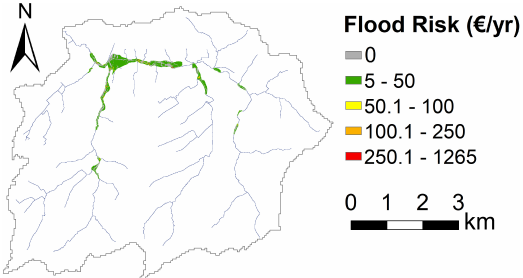
Figure 8. Flood risk, expressed as expected annual damages (EUR per year) in each pixel (5m × 5m resolution), in the Maarkebeek catchment based on the four observed flood events. Flood risk is highly localized and highest (EUR1265 per year or EUR50.6 per year per square meter) in only a few, built-up pix- els which were repeatedly flooded. The total flood risk derived from the four flood events in the Maarkebeek catchment equals EUR178252 per